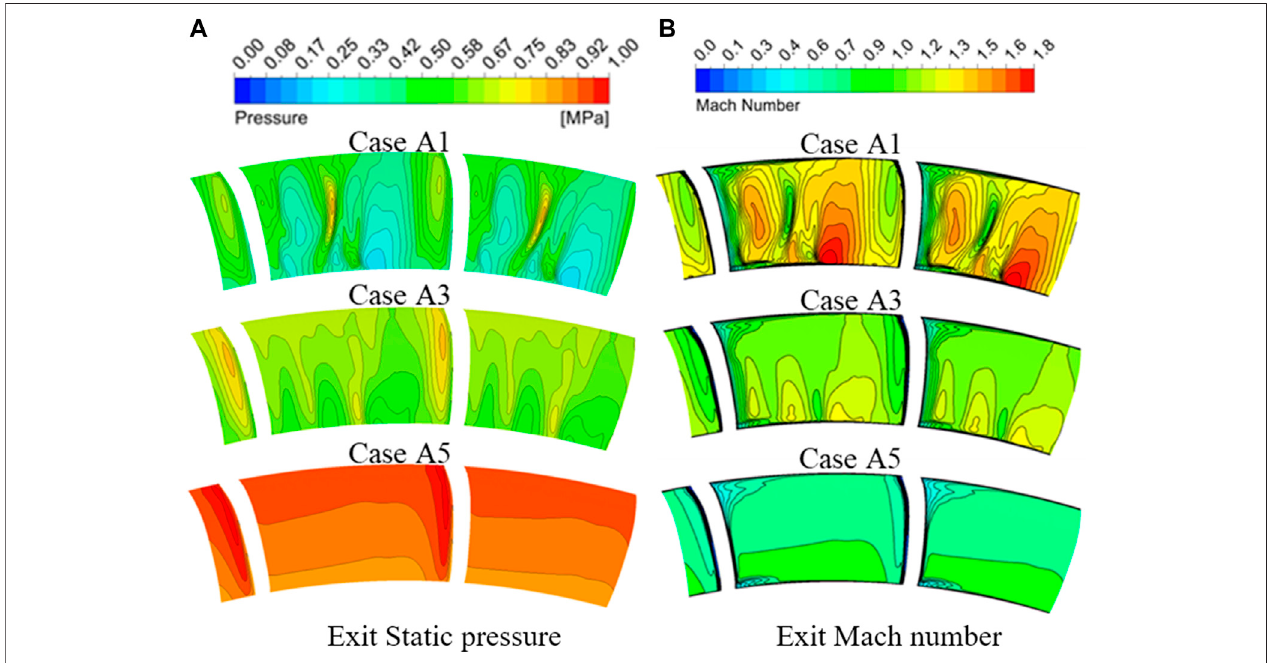
FIGURE 9 | Exit Static pressure and Mach number distribution of stators. (A) Exit Static pressure. (B) Exit Mach number.